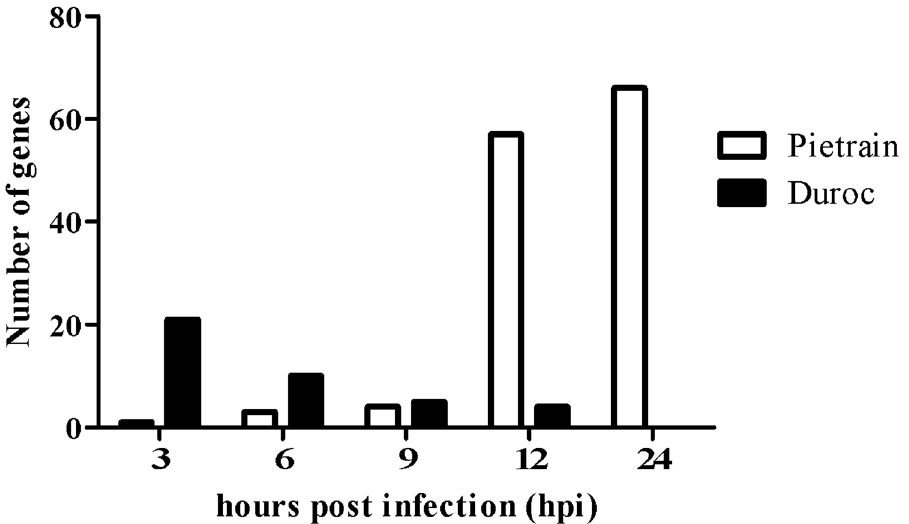
Fig 2. Number of down-regulated genes during the course of PRRSV infection. Pietrain (white bar) and Duroc (black bar) lung DCs at 3, 6, 9, 12, 24 hpi (p (cid:20) 0.05 and FDR (cid:20) 10%).